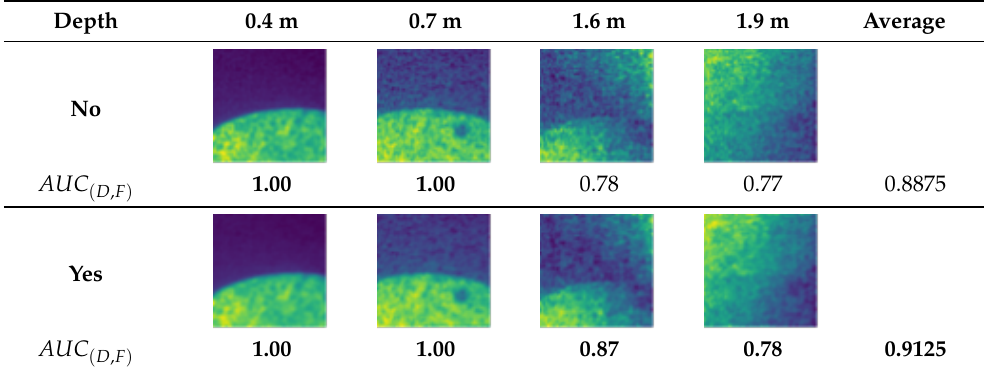
Table 13. The effect of the spatial–spectral process on the detection of stone